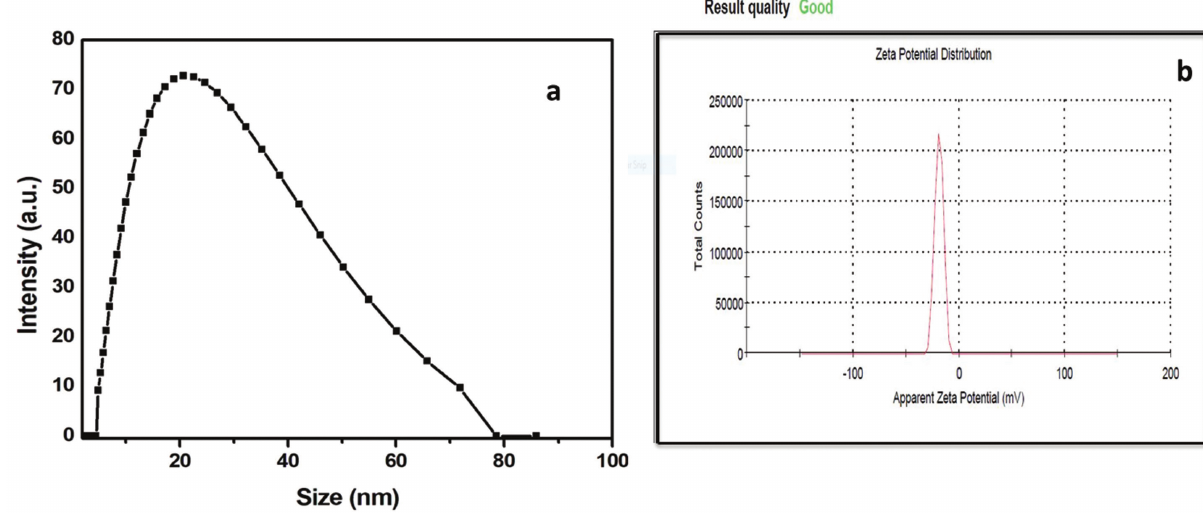
Figure 3: (a) Particle size distribution of synthesized TiO